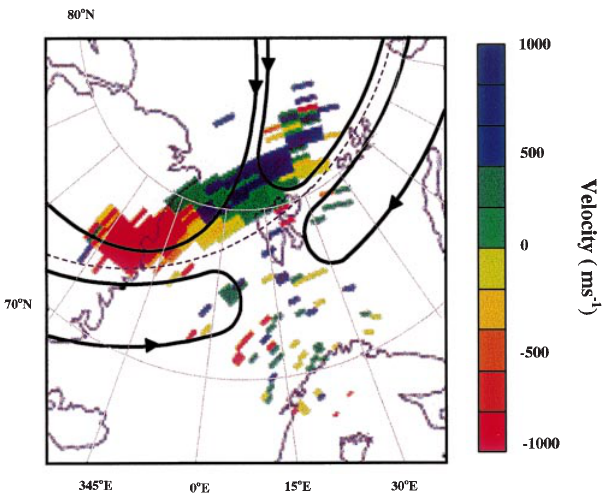
Fig. 2. Line-of-sight velocities measured by the Finland radar of the CUTLASS Superdarn facility at 0852 UT on a geographic grid. The positive values represent flows towards the radar and negative values flows away. Superimposed are flow stream lines ( solid curves ) and the adiaroic boundary ( dashed curve ) reminiscent of a portion of the Cowley (1998) pattern for the prevalent